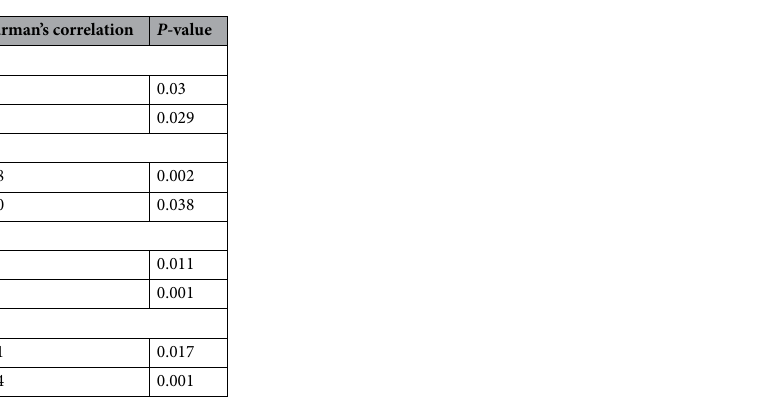
Table 3. P -values of biological, clinical gender, and age related to both biomarkers in the experimental groups. P -values were measured by Mann–Whitney test.